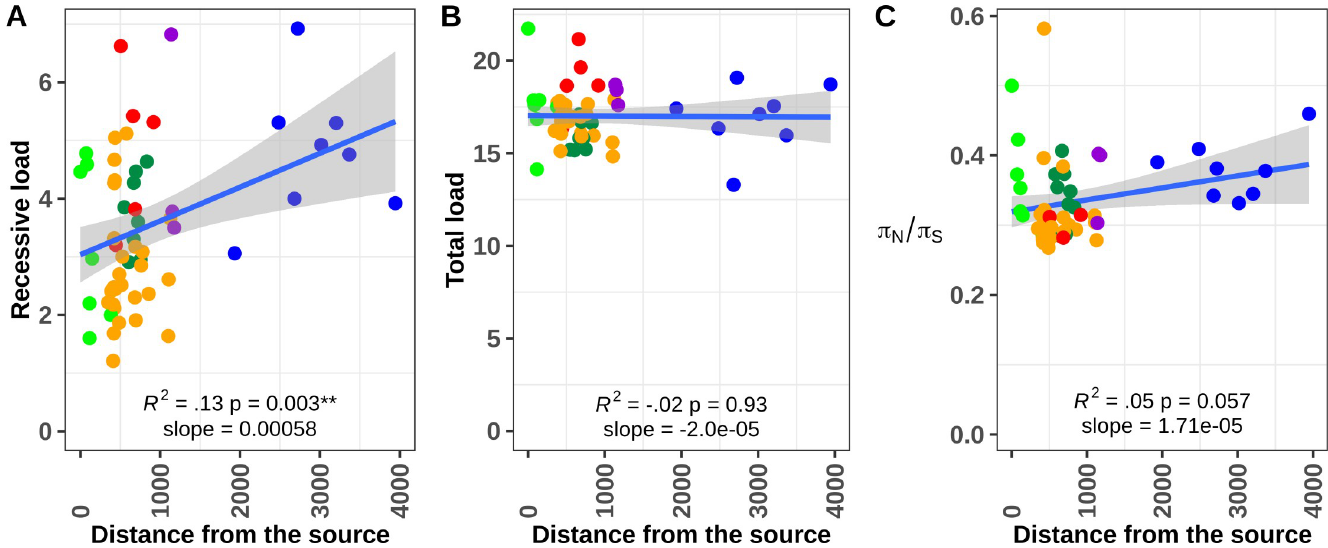
Fig 6. Expansion history and geographic pattern of deleterious mutation load: Correlation between the distance to the southernmost site and the deleterious load measured as (A) the distribution of homozygous derived putatively deleterious mutations (i.e. recessive load). B) the total load expected to be approximately constant among all populations) and C) the π N / π S ratio. R 2 = coefficient of determination of the linear model.